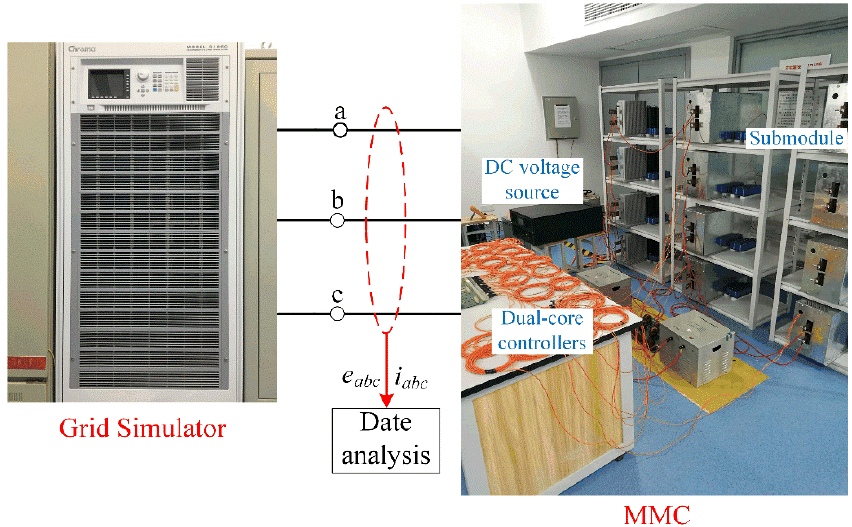
Figure 7. Photograph of the experimental setup.